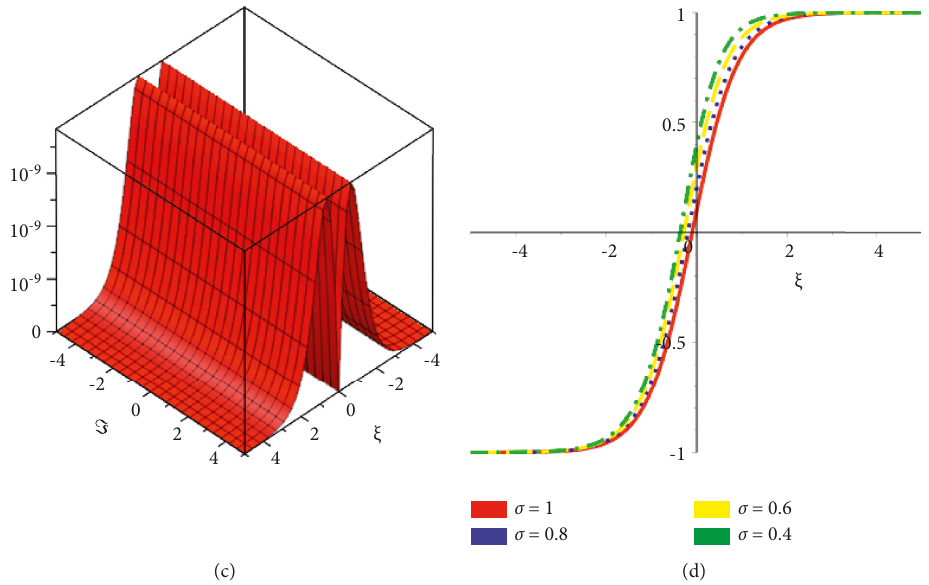
Figure 4: Exact solution, analytical solution, absolute error, and various fractional order solutions for ] ( ξ , I ) of problem 2.